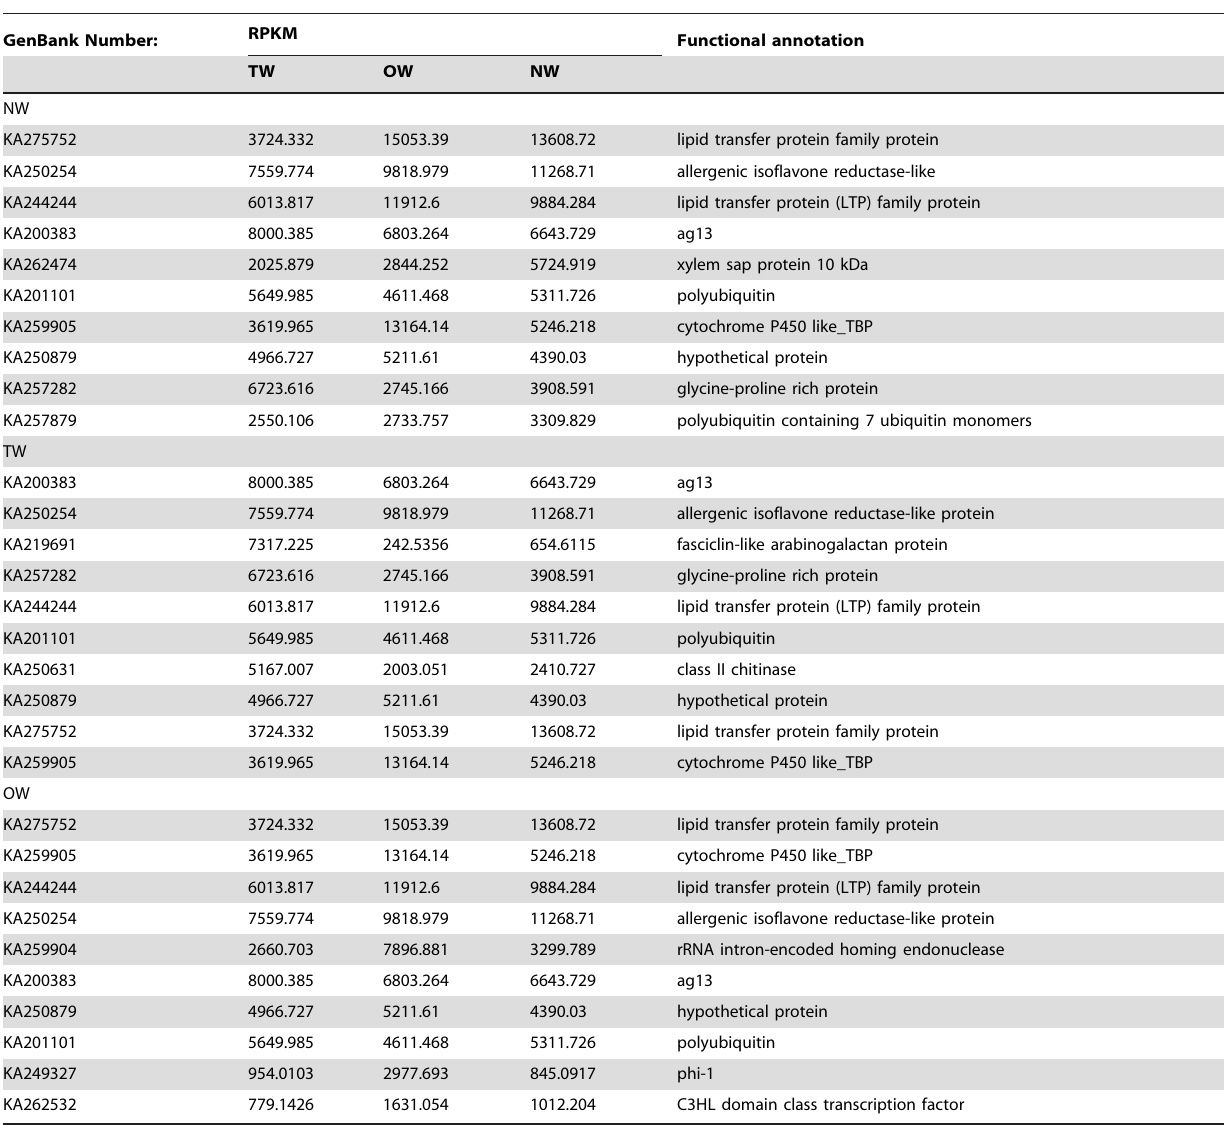
Table 2. Expression profiles of the top 10 abundant genes in TW, OW and NW.